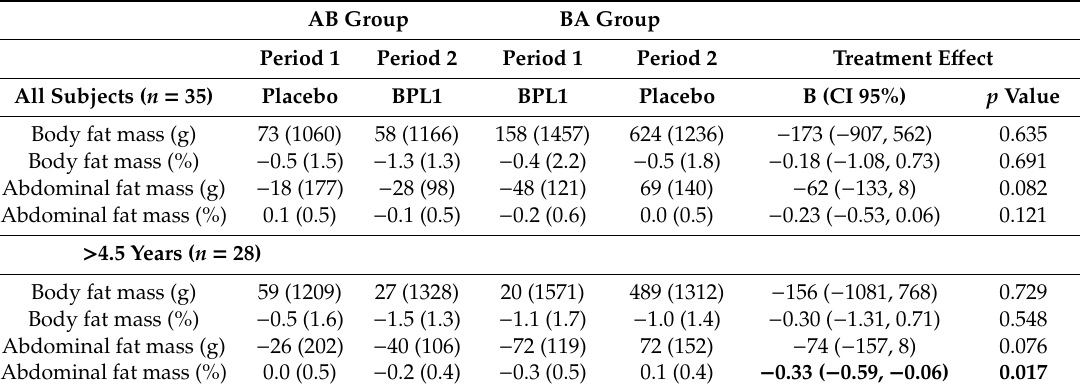
Table 2. Treatment e ff ects on adiposity.